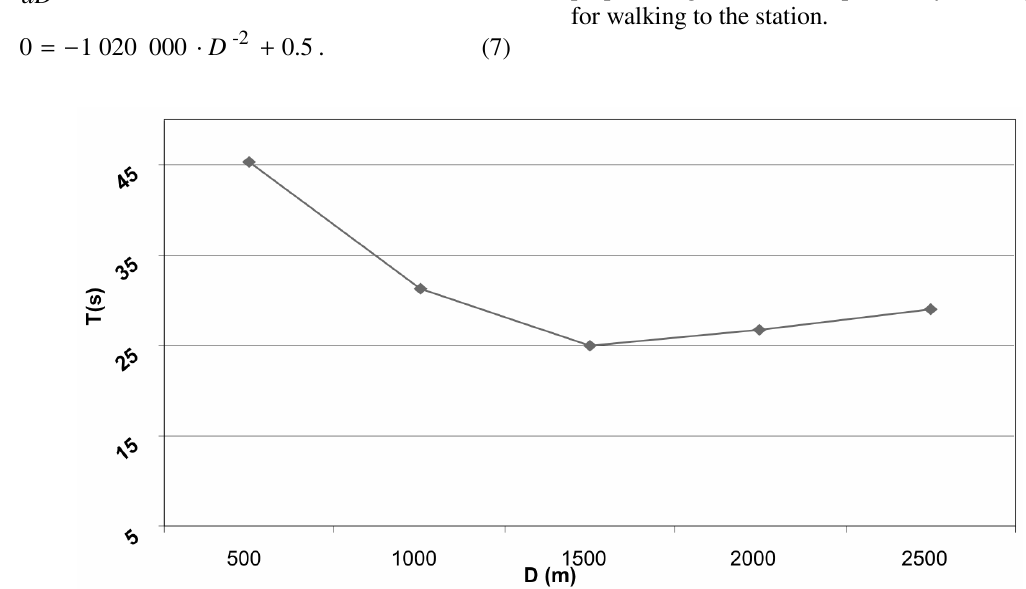
Fig 1. Relation between travel time and station